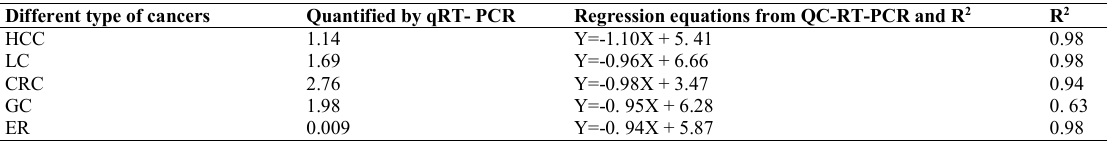
Table 2. Quantification of miRs levels in different cancers by QC-RT-PC